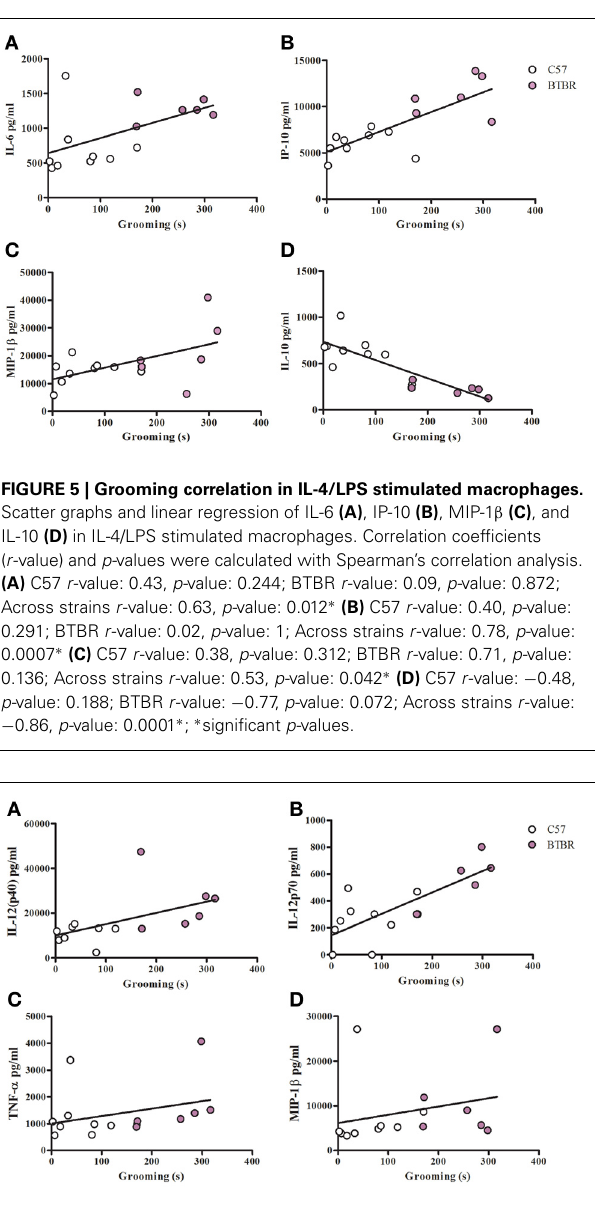
FIGURE 6 | Grooming correlation in IFN γ /LPS stimulated macrophages. Scatter graphs and linear regression of IL-12(p40) (A) , IL-12(p70) (B) , TNF α (C) , and MIP-1 β (D) in IFN γ /LPS stimulated macrophages. Correlation coefficients ( r -values) and p- values were calculated with Spearman’s correlation analysis. (A) C57 r -value: 0.26, p- value: 0.536; BTBR r -value: 0.09, p- value: 0.919; Across strains r -value: 0.72, p- value: 0.004 ∗ (B) C57 r -value: 0.39, p- value: 0.291; BTBR r -value: 0.87, p- value: 0.033 ∗ ; Across strains r -value: 0.77, p- value: 0.001 ∗ (C) C57 r -value: 0.02, p- value: 0.966; BTBR r -value: 0.94, p- value: 0.005 ∗ ; Across strains r -value 0.51, p- value: 0.005 ∗ (D) C57 r -value: 0.70, p- value: 0.036 ∗